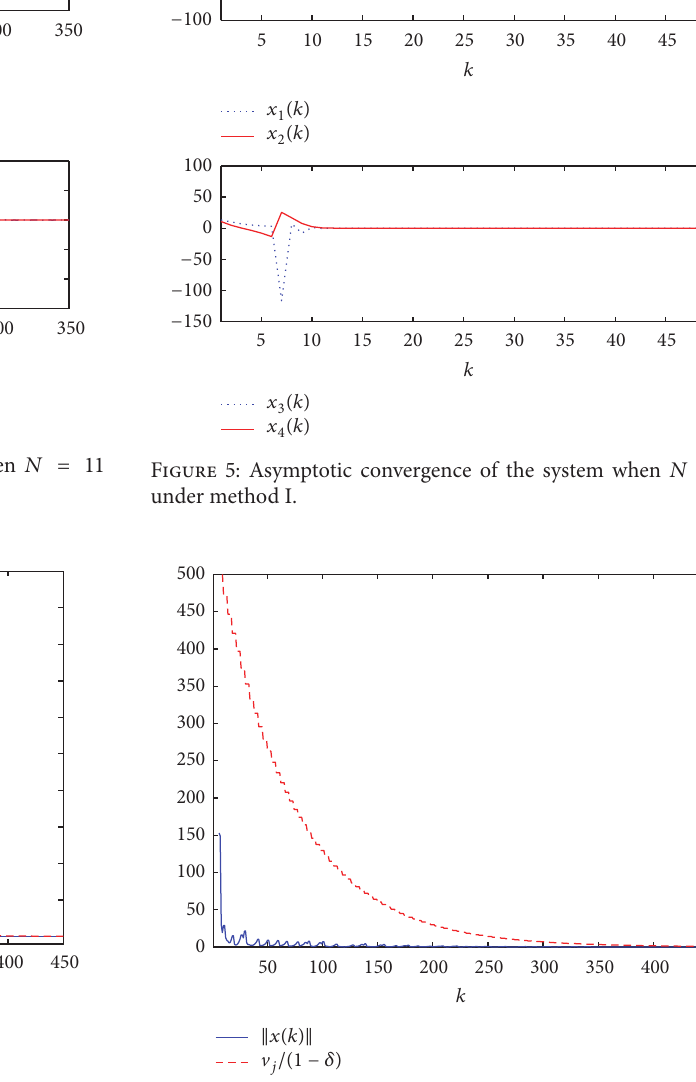
Figure 6: Unsaturation of the quantizer when 𝑁 = 60 under method